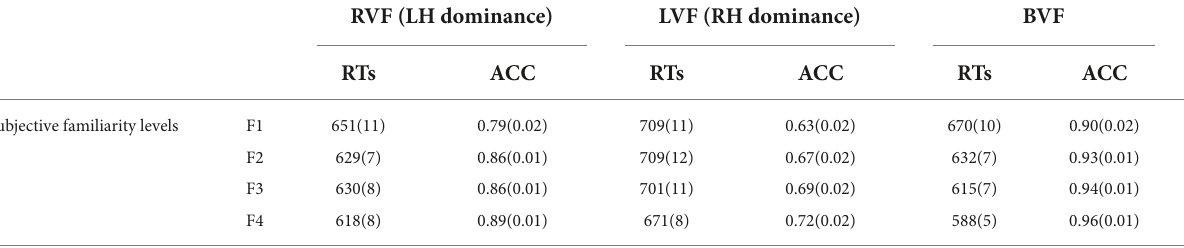
TABLE 4 Results of response times (RTs) and accuracy (ACC) at each visual field (RVF, LVF, and BVF) were shown according to the level of subjective familiarity with